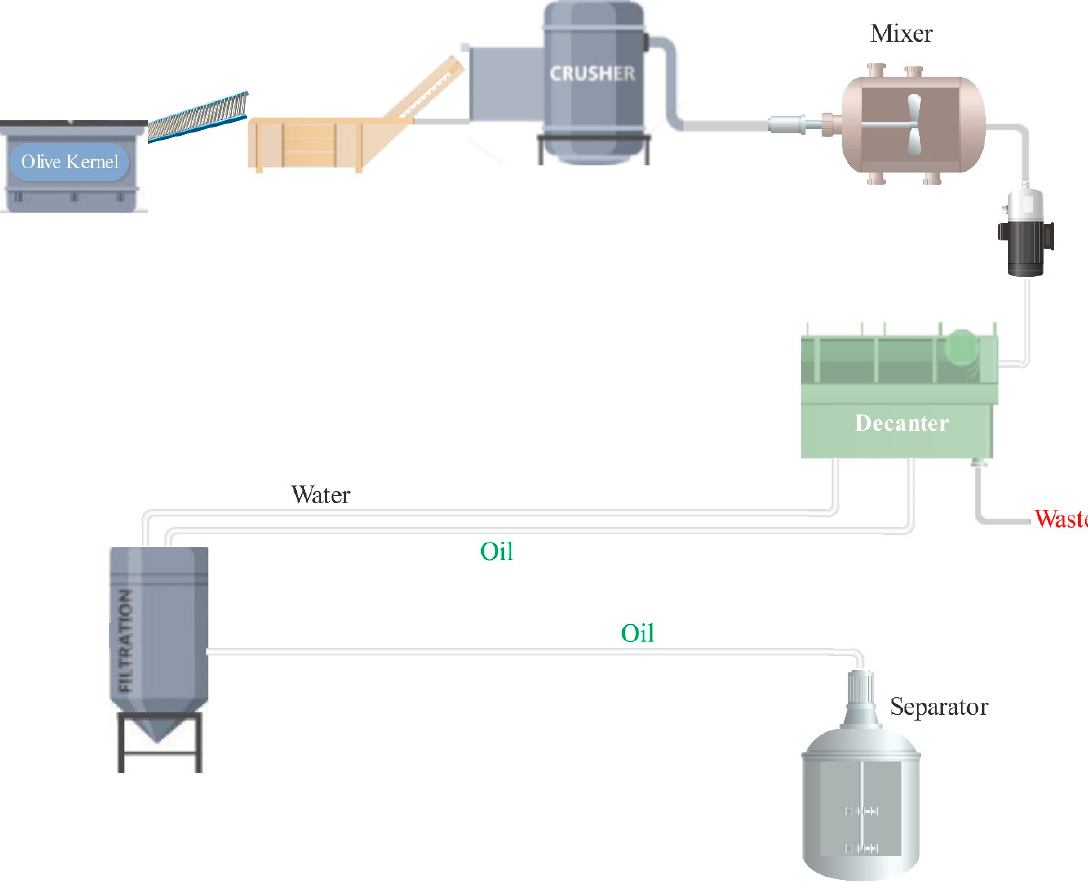
Figure 3. Olive oil production line with a daily production capacity of 100 kg.